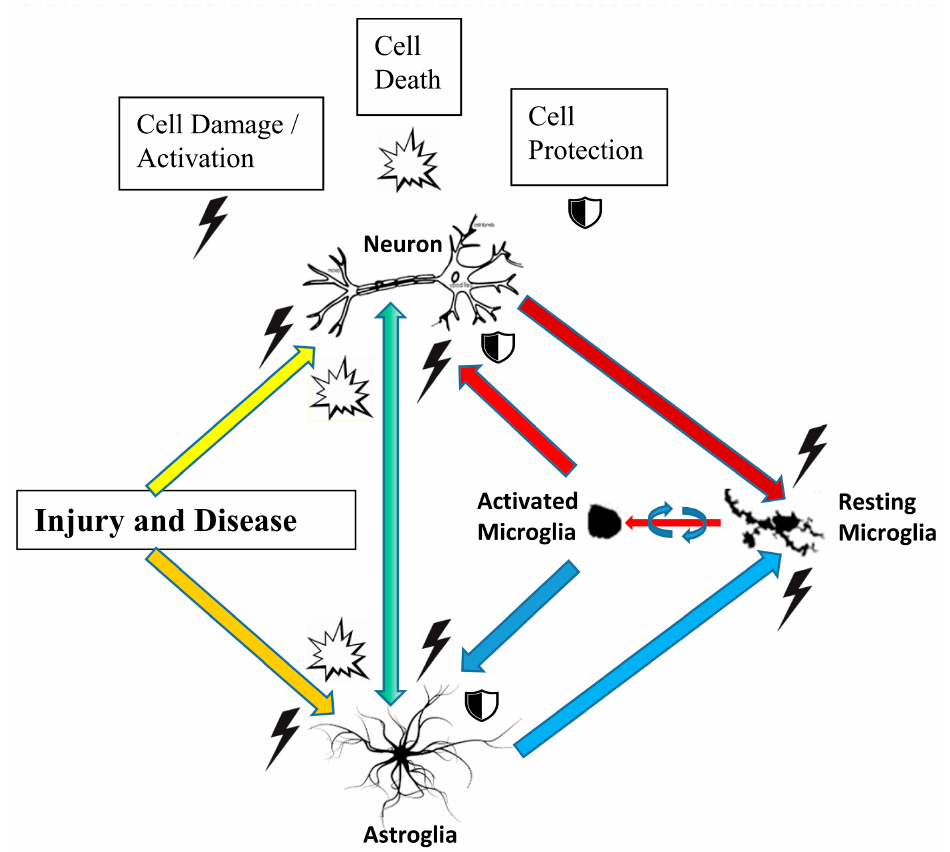
Figure 2. Schematic overview of interactions between neurons, astroglia, and microglia in the CNS, as they can occur due to brain injury and brain disease. The effects of raloxifene and other selective estrogen receptor modulators (SERMs) on these cell types and their interactions in relation to brain injury and disease are discussed in Section 3: Brain Cell Types and the Effects of Raloxifene.